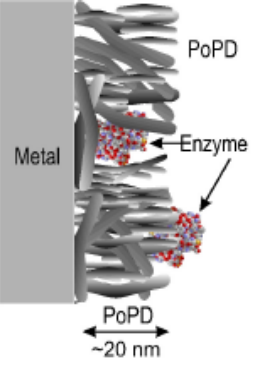
Figure 3. Immobilization of GOx in/on a PoPD layer on a platinum electrode